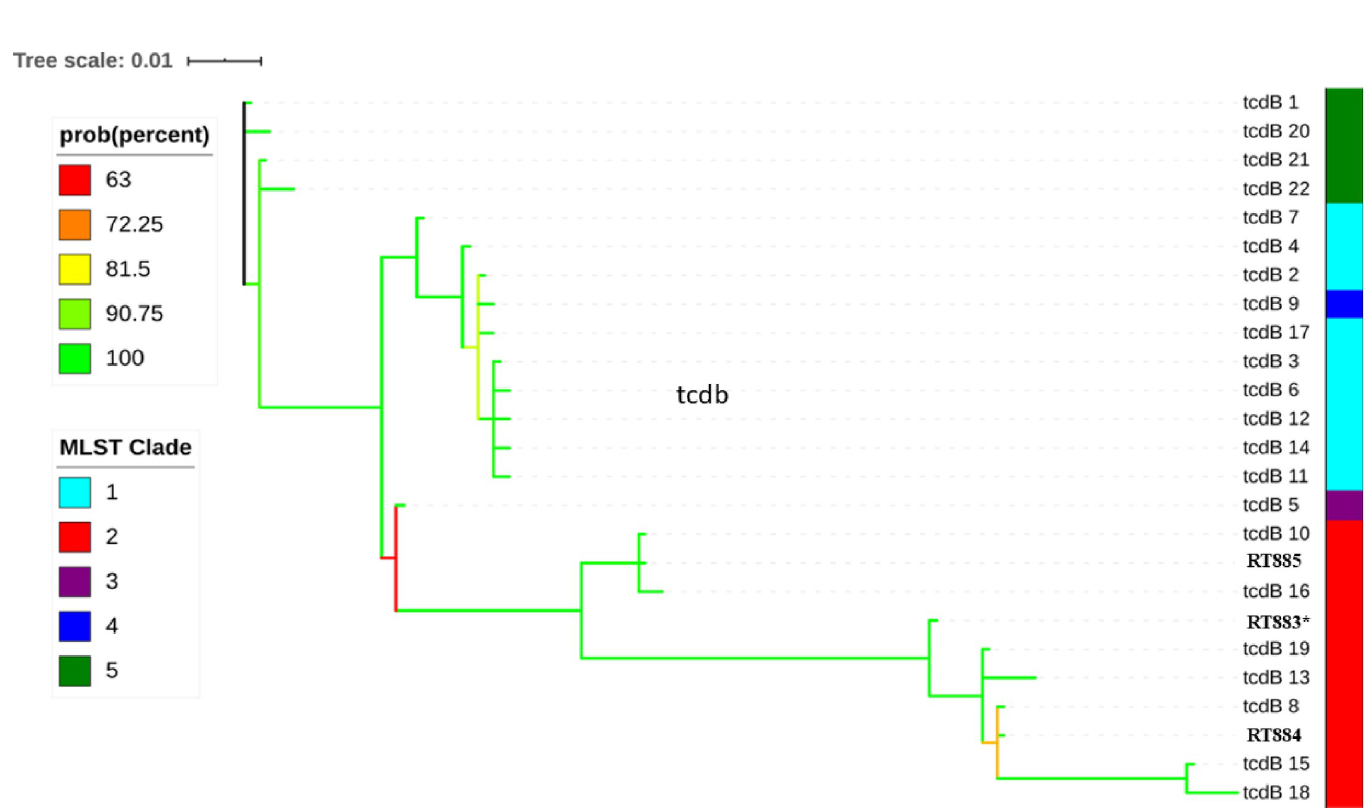
Fig 5. Phylogenetic analysis by Bayesian estimation of the amino acid sequences of tcdB alleles from the three Brazilian clade 2 strains (RT883, 884, and 885). The distribution of alleles according to different clades is shown on color strip in the right. Posterior probability branch support is denoted by a color code, from red (65% support) to green (100% support). ( � ) A novel allele ( tcdB 23) was identified in RT883, while tcdB alleles 8 and 10 were identified in RT884 and RT885, respectively.